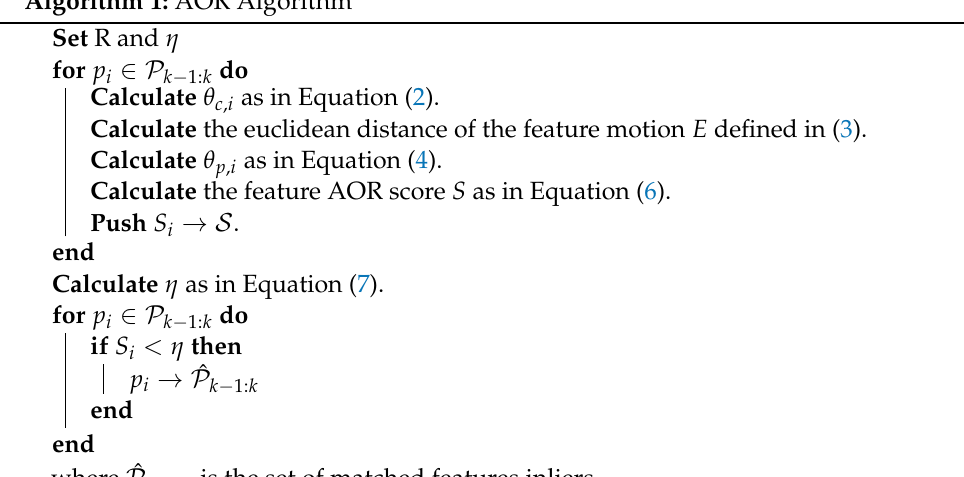
Algorithm 1: AOR